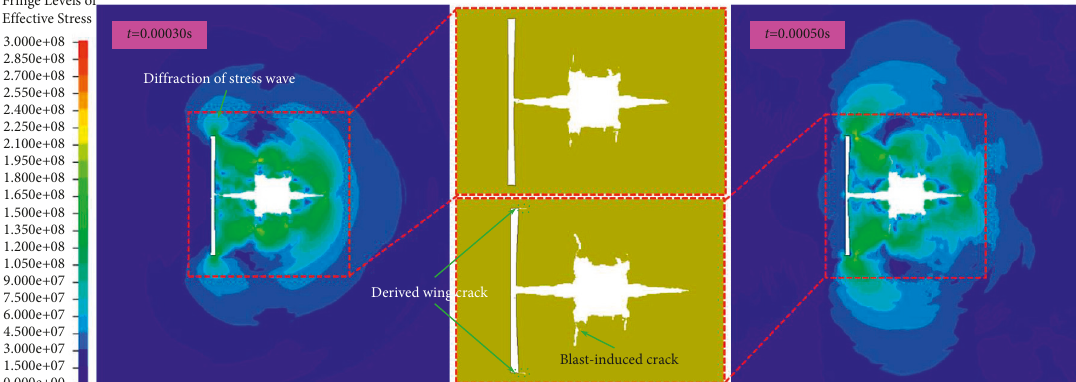
Figure 12: Pressure diagram of explosion stress wave transmission for case CN